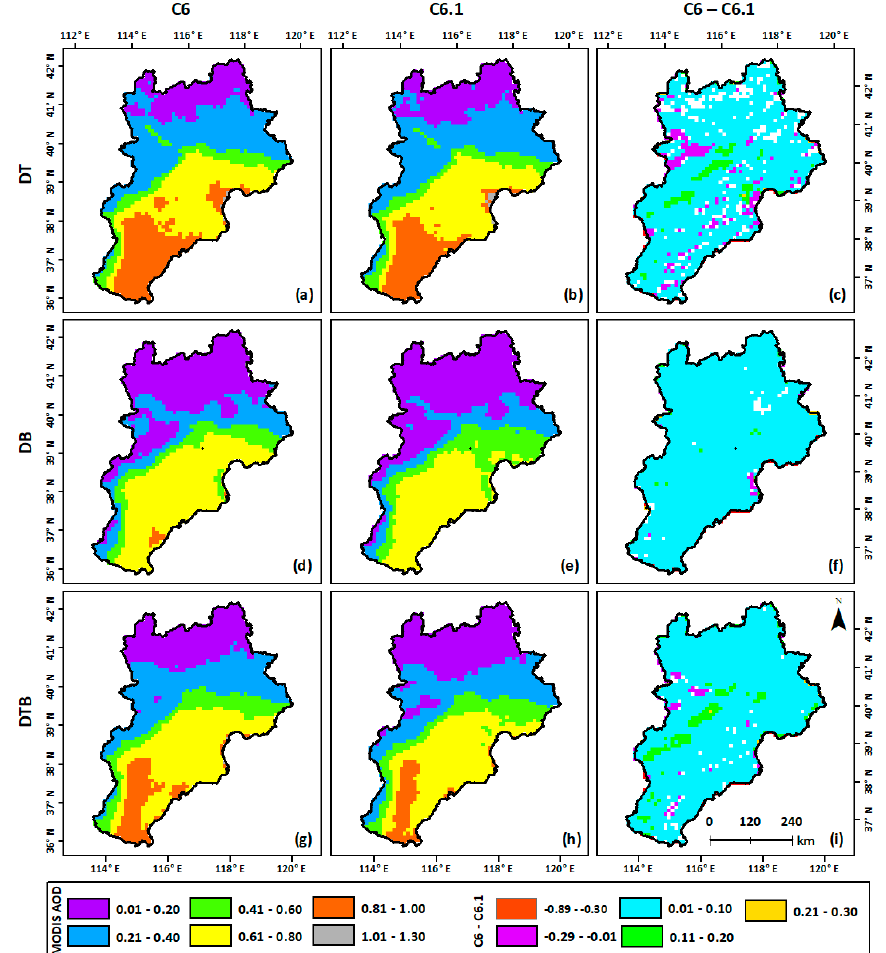
Figure 6. Spatial comparison between C6 and C6.1 AOD retrievals from 2004 to 2014 over the BTH region, where ( a ), ( b ) and ( c ) represent DT C6, C6.1 and C6 – 6.1, ( d ), ( e ) and ( f ) represent DB C6, C6.1 and C6 – 6.1, and ( g ), ( h ) and ( i ) represent DTB C6, C6.1 and C6 – 6.1, respectively. In order to evaluate DT and DB AOD over different land surfaces and understand their relative contributions to DTB AOD, each as validated over diverse vegetated surfaces (Figure 7) defined by NDVI: non-vegetated surfaces (NVS, NDVI < 0.2), partially-vegetated surfaces (PVS, 0.2 ≤ NDVI ≤ 0.3), moderately-vegetated surfaces (MVS, 0.3 < NDVI < 0.5) and densely-vegetated surfaces (DVS, NDVI ≥ 0.5) [27]. For DT C6.1 (C6), the 52 (65), 535 (503), 981 (961), and 312 (311) collocations were available for NVS, PVS, MVS, and DVS, respectively. The RMSE (RPME) of DT C6.1 AOD was reduced from 0.12 (22%) to 0.09 (19%) for NVS, 0.28 (50%) to 0.17 (25%) for PVS, and 0.30 (28%) to 0.23 (19%) for MVS, and no significant improvements were observed for DVS. DT C6 and C6.1 collocated retrievals did not fulfill the requirements of EE for PVS and MVS, as the percentage of retrievals ↔ EE was less than 66% [28]. Relatively good performance from the DT algorithm was in fact expected, as it was designed and developed to retrieve accurate AOD for vegetated surfaces. Only DT AOD was considered in DTB for MVS, which introduced the same errors as observed in DT as shown in Figure 7s,w. Overall, the improvements observed in C6.1 compared to C6 were mainly due to the modified estimated surface reflectance.